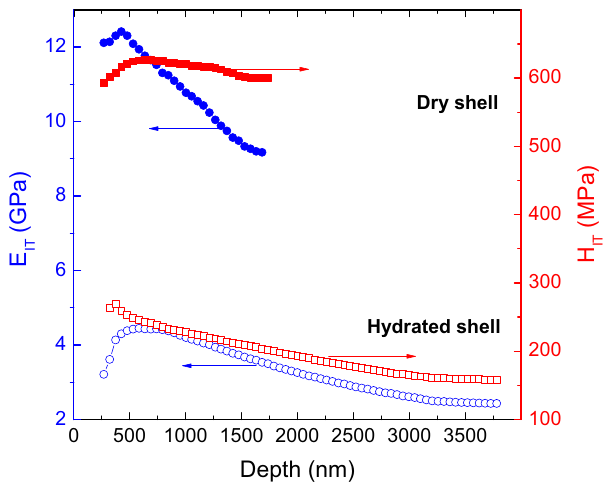
Fig. 2 Depth-dependent dynamic nanoindentation measurements of D. tenuis brachiopod shell samples at different hydration levels. Plotted is the dependence of shell hardness H IT (red, right) and Young ’ s modulus E IT (blue, left) as a function of indentation depth for an atmospherically dry shell sample (top, fi lled symbols) and a fully hydrated shell sample (bottom, open symbols). Measurements were conducted in continuous stiffness mode up to a maximum force of 30 mN. Shown is the average over eight indentation